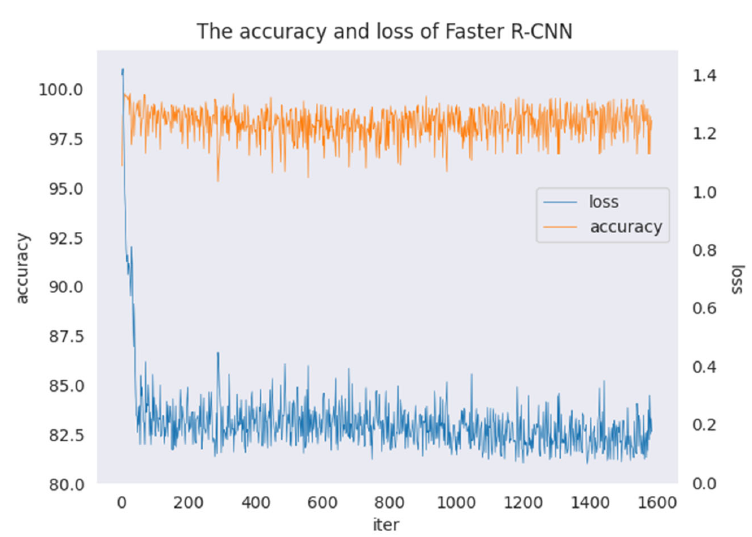
Figure 15. The accuracy and loss of faster R ‐